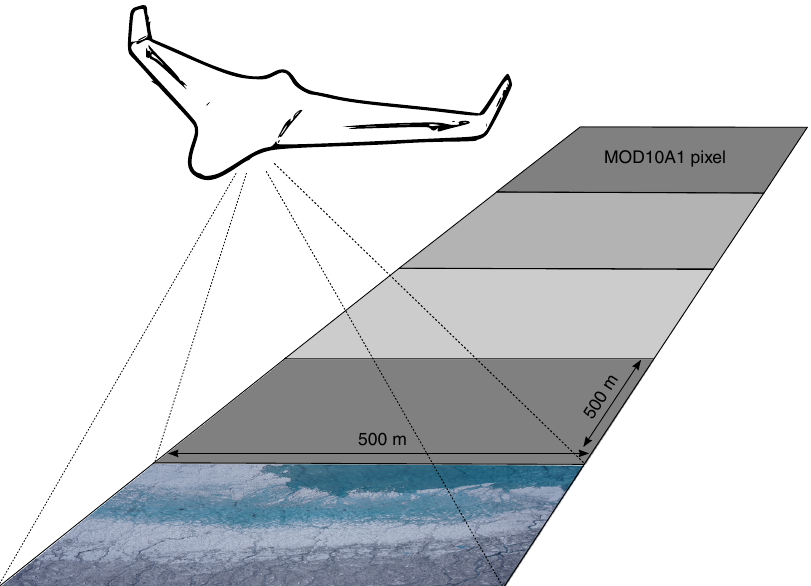
Fig. 2 Schematic summarizing the aims of the study. Aerial digital imagery are used to characterize the surface types that are found in the ablation zone and assess their impact on mesoscale spatial albedo patterns as represented by MODIS